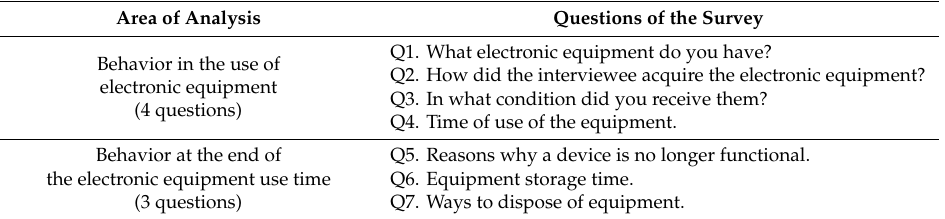
Table 3. Relationship between the area of analysis and the